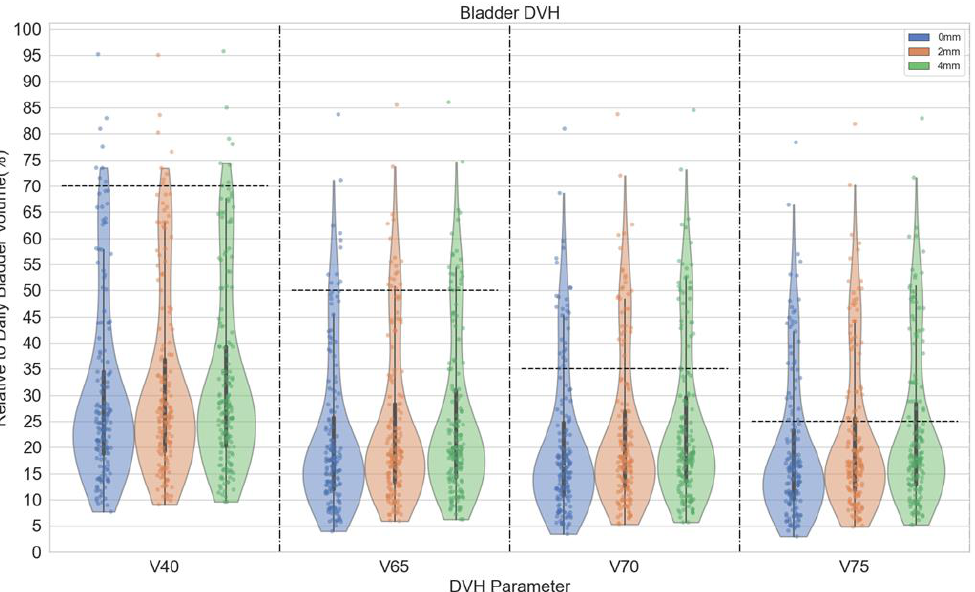
Figure 5. Violin plot for bladder DVH parameters for all patients. The parallel dash lines indicate the dose constraints. These DVH parameters were listed to show plan quality change. Dashed lines were commonly used dose constraints from literature or other practice guidelines.